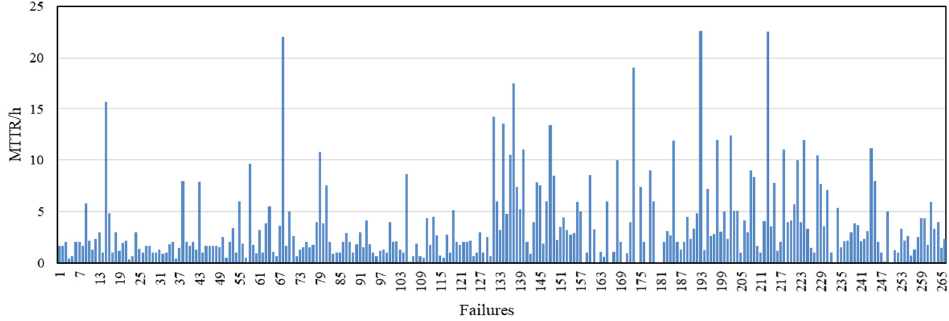
Figure 12. MTTRs of the 266 failures.